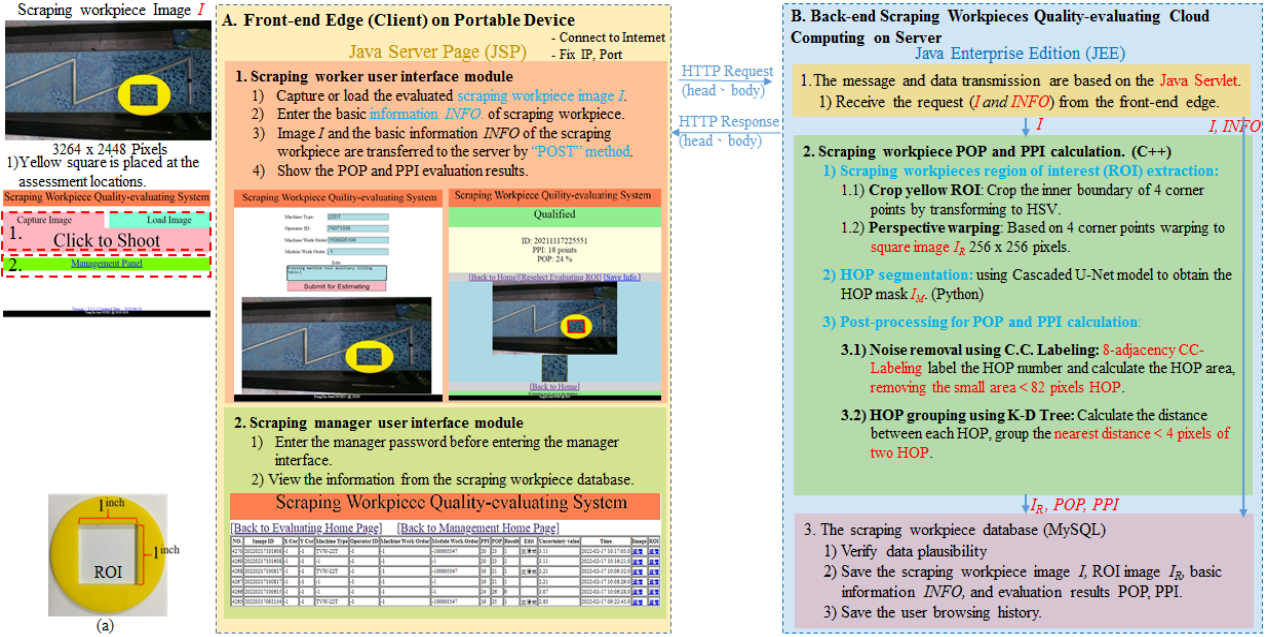
Figure 3. The structure of scraping workpiece quality-evaluating edge-cloud system. ( a ) The size of the yellow square. the yellow